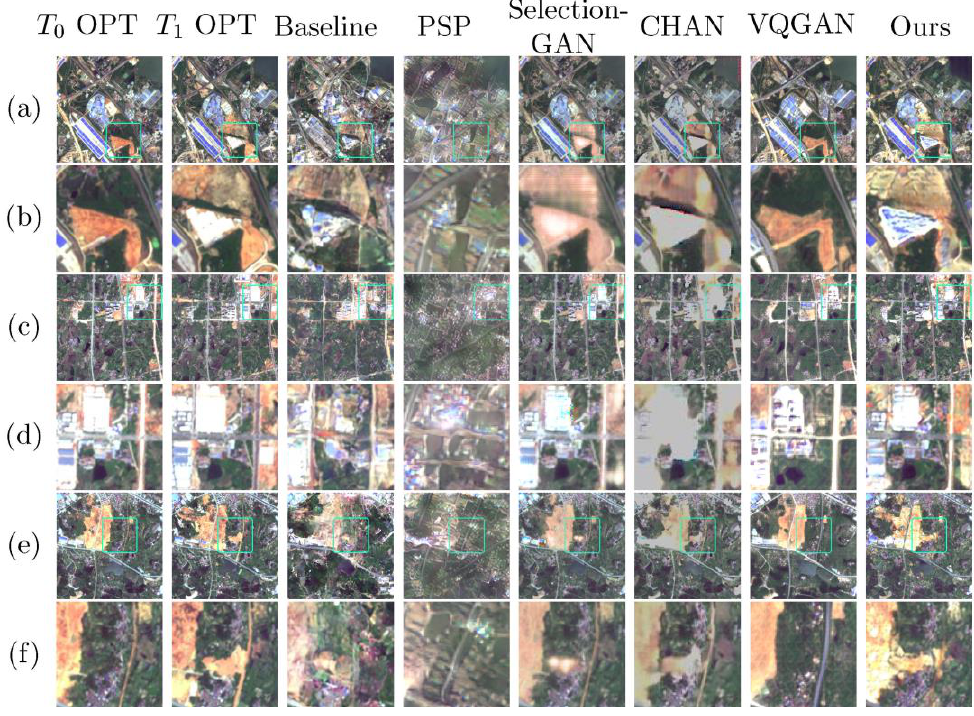
Figure 11. Visual comparison under a complicated scenario. Three samples are given in ( a , c , e ). Some regions in ( a , c , e ) are marked with rectangles and enlarged in ( b , d , f ) respectively.